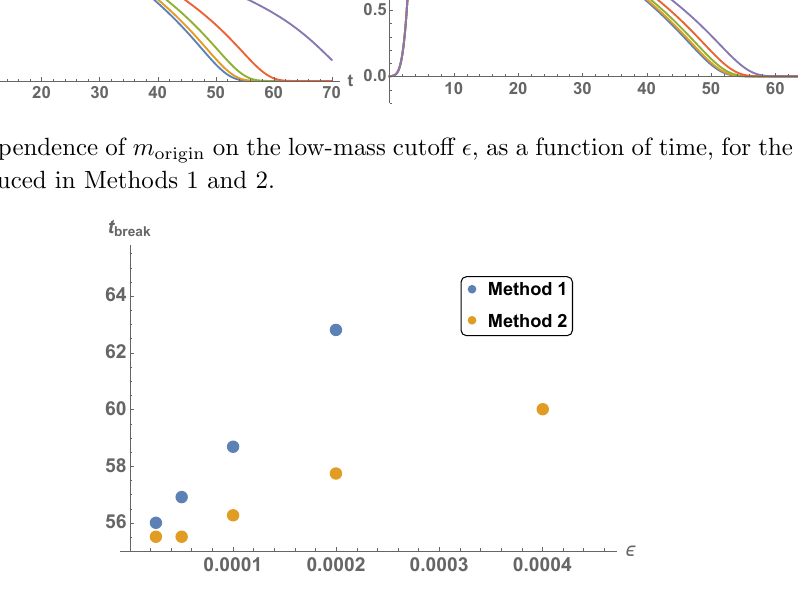
Figure 17 . Dependence of t break as a function of the low-mass cuto(cid:11) (cid:15) , for both methods. rates of energy and angular momentum for uniform, rigidly rotating objects (such as the rotating ellipsoidal bar) are related in a simple manner, eq.